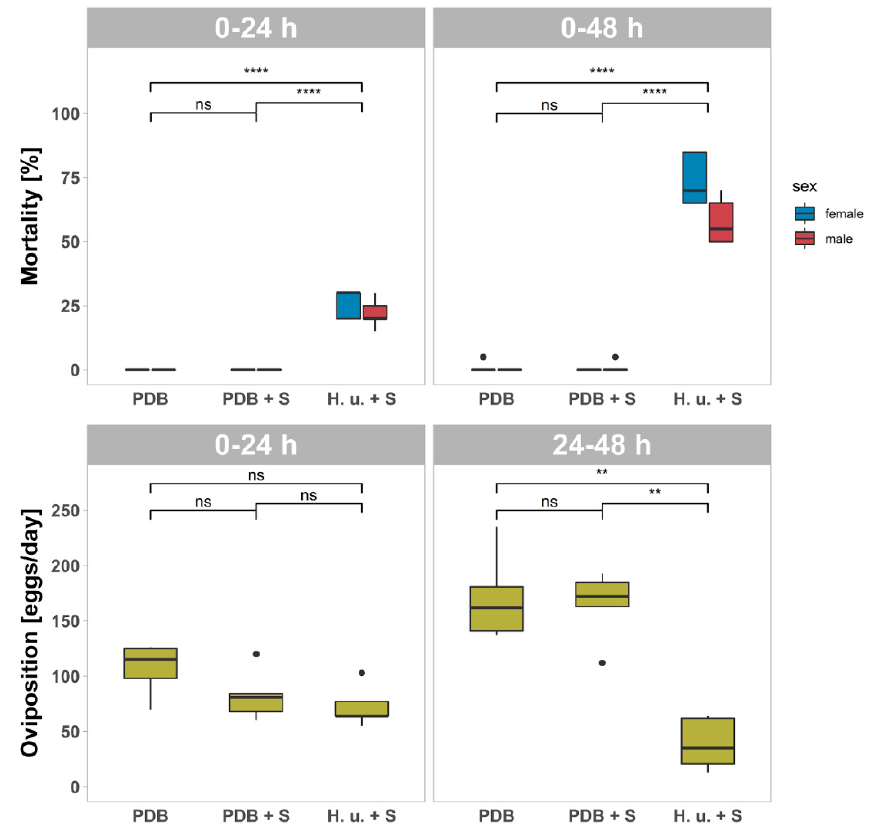
Figure 3. Mortality and Oviposition ( ± SD; n = 5) of SWD adults (20 males and 20 females) after the exposure to leaves treated with PDB, PDB plus spinosad (PDB + S), or H. uvarum plus spinosad (H. u. + S) one week after treatment (T2). Mortality of males and females after 24 h and after 48 h of exposure. Oviposition after the first 24 h and between 24 and 48 h of exposure. Asterisks indicate significant differences between the treatments ( p < 0.05). Not significant differences are reported, as well (ns). Outliers are indicated with dots. ≤ 0.01 = **; ≤ 0.0001 =